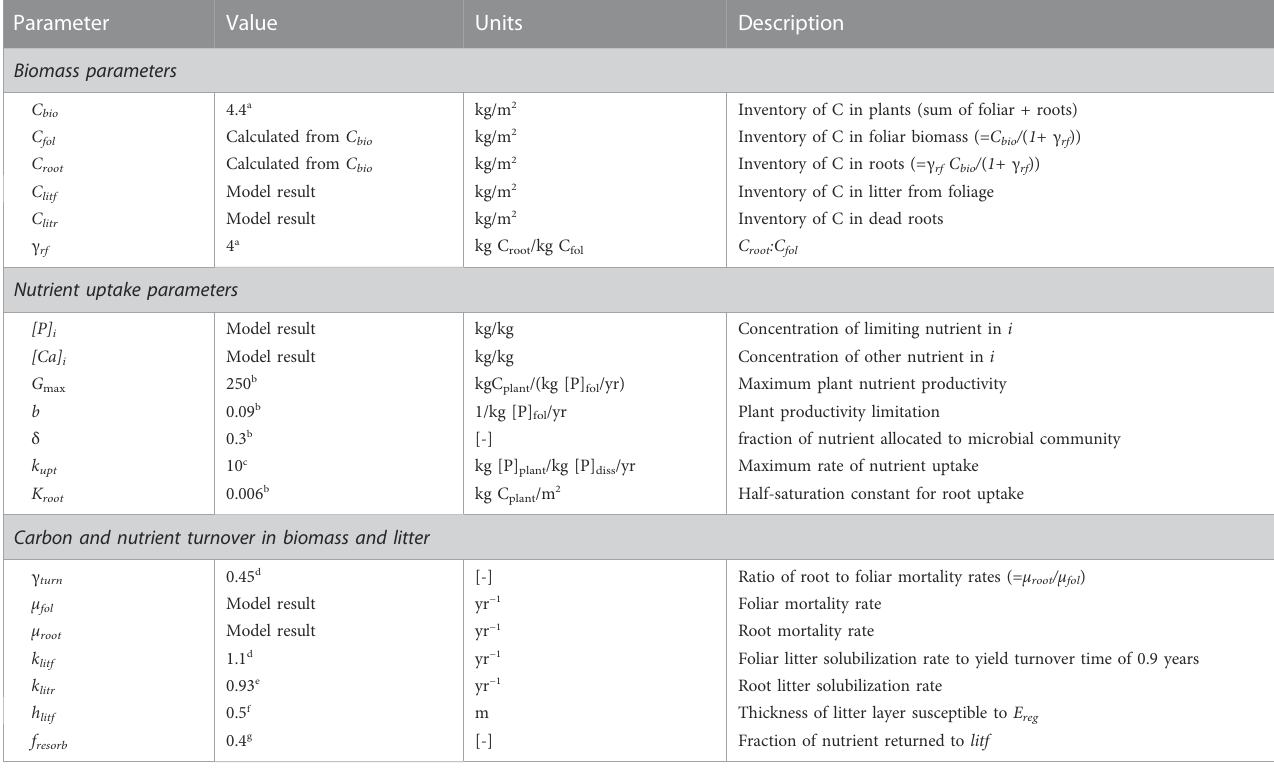
TABLE 1 Parameter values and descriptions for nutrient uptake equations. Parameters computed using the model framework are designated as “ model result ” , whereas for other values the range considered is provided with the “ reference ” value in parentheses. The reservoir is indexed according to i as described in text and Figure 1 ( i =bio, fol, etc. ). [-] denotes unitless